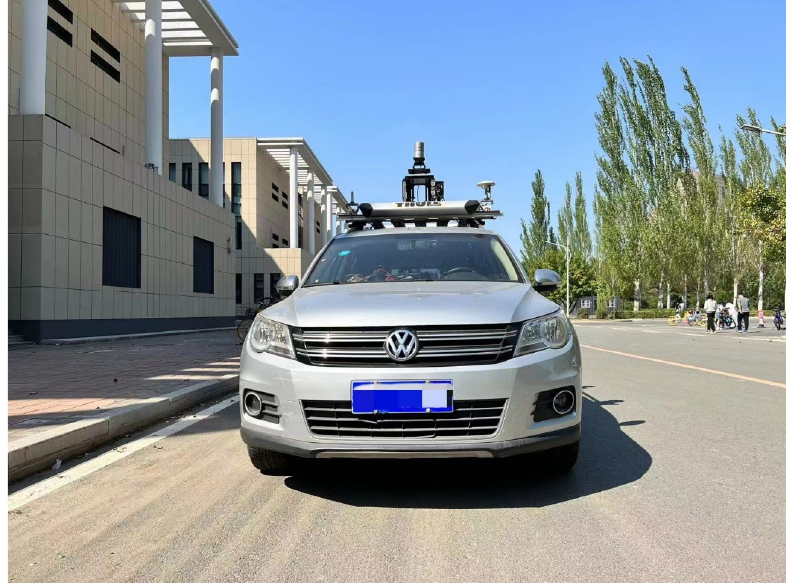
Figure 10. Mobile platform equipped with sensors (Volkswagen Tiguan). Table 2. Details of the JLU campus dataset.